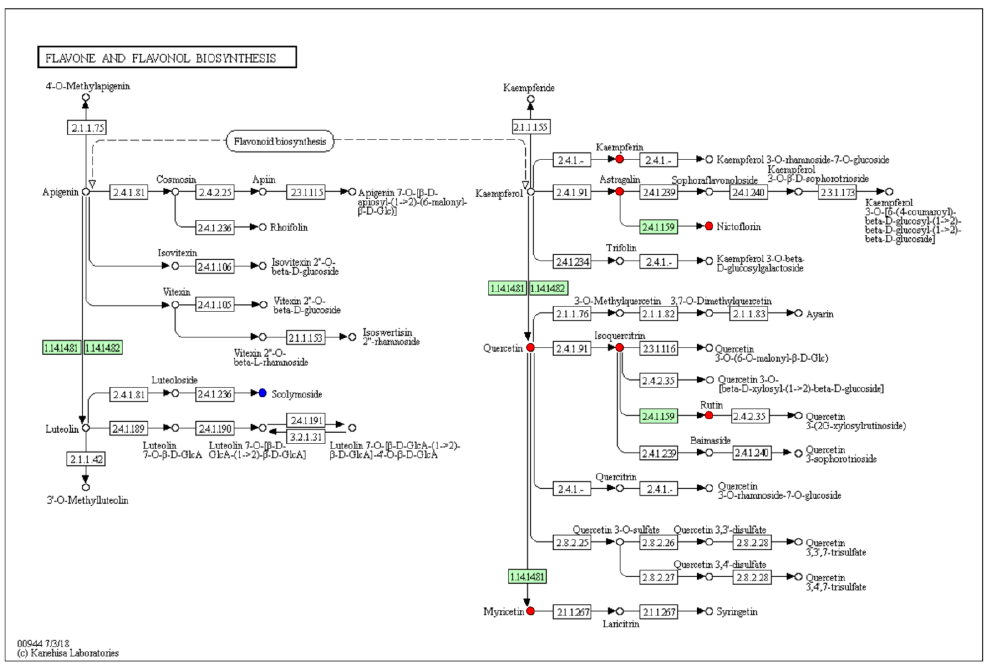
Figure 8. Flavone and flavonol biosynthesis (https://www.kegg.jp/entry/map00944 (accessed on 10 January 2022)). Blue and red round dots represent down-regulated metabolite and up-regulated metabolite, respectively.